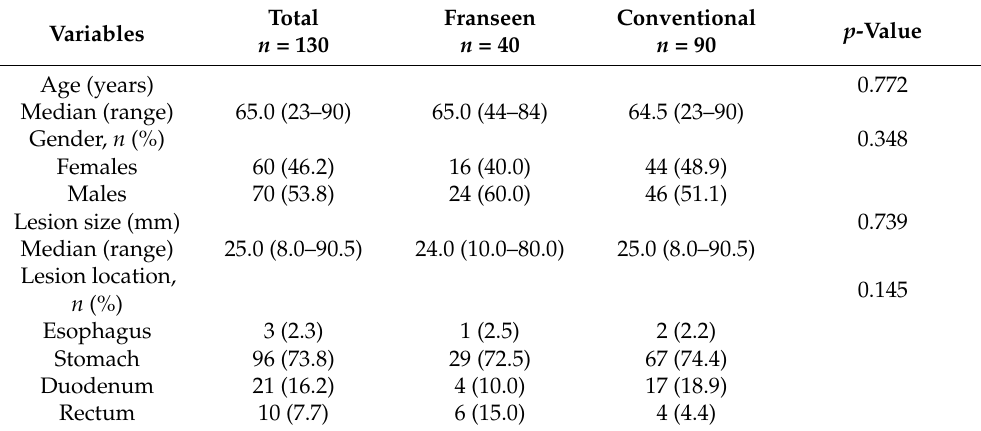
Table 1. Patient and lesion characteristics of cases with EUS-FNA for SELs ( n = 130).